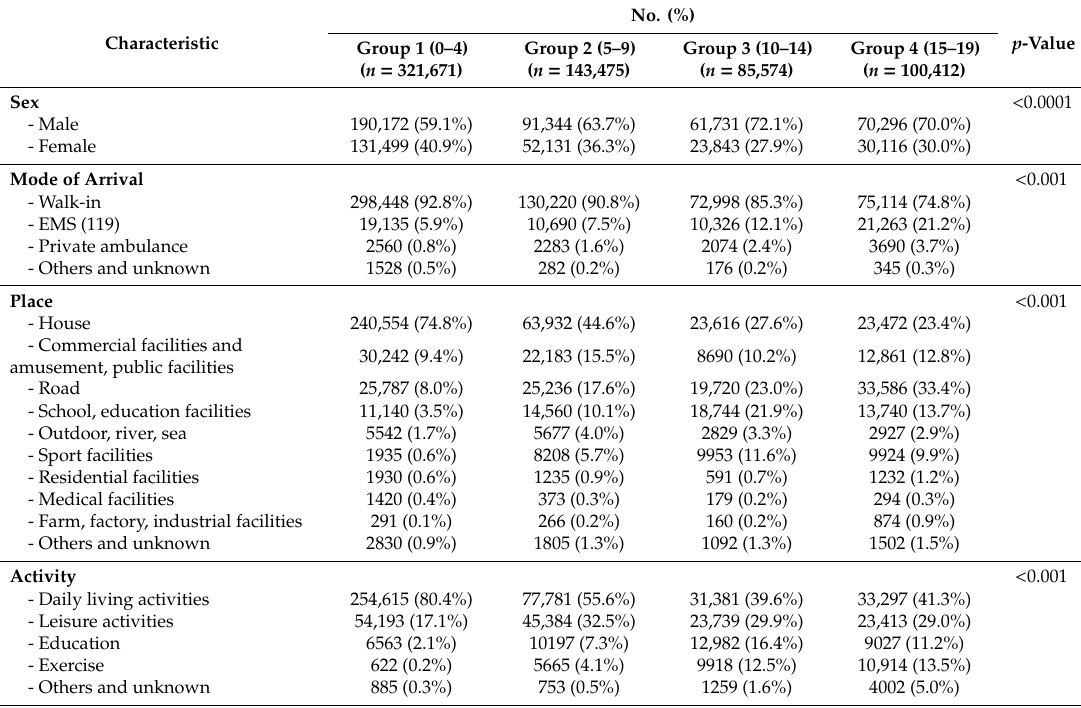
Table 1. General characteristics of pediatric injury patients by age